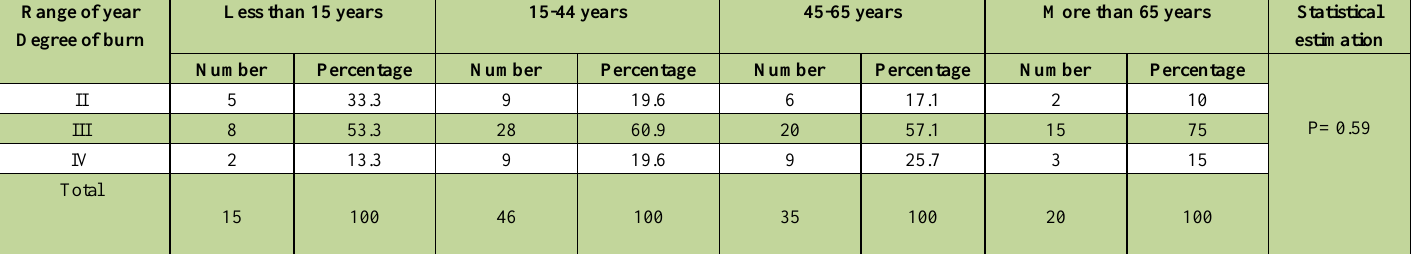
Table 9. Frequency Distribution of Burn Degrees in Patients Admitted to ICU by Age